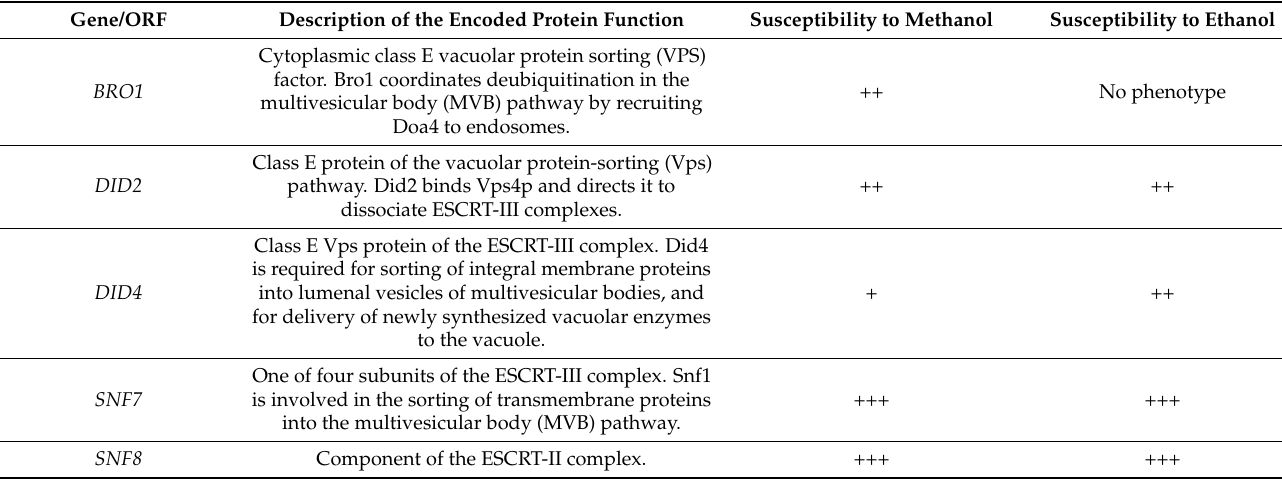
Table 5. Genes involved in vesicular transport identified in this study as determinants of yeast tolerance to methanol, compared with ethanol. Symbols are as in Table